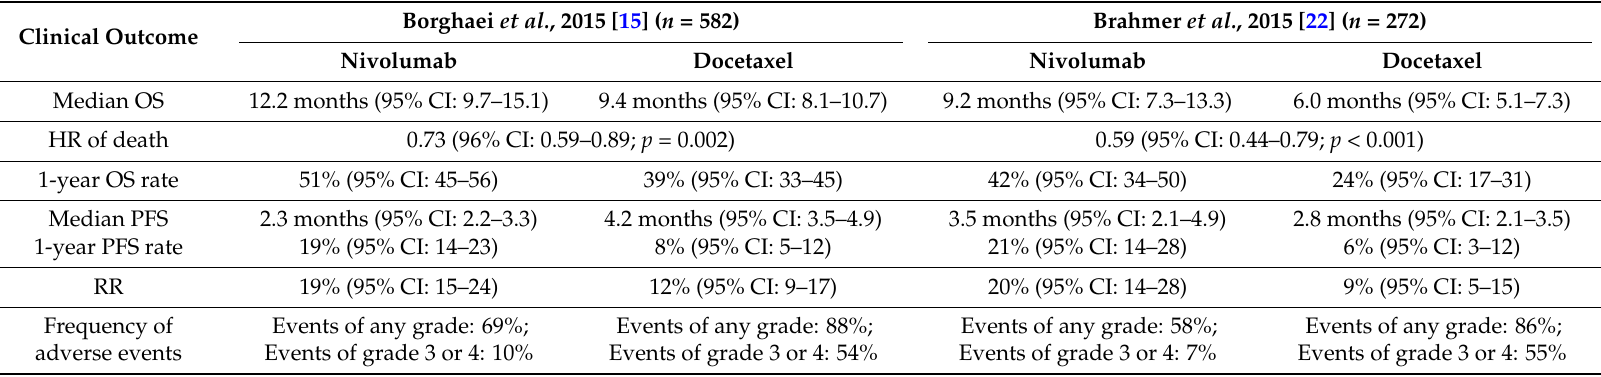
Table 2. Comparison of the clinical outcomes of patients resulting from the use of nivolumab and docetaxel in NSCLC treatment in a clinical study by Borghaei et al. , 2015 and Brahmer et al. ,